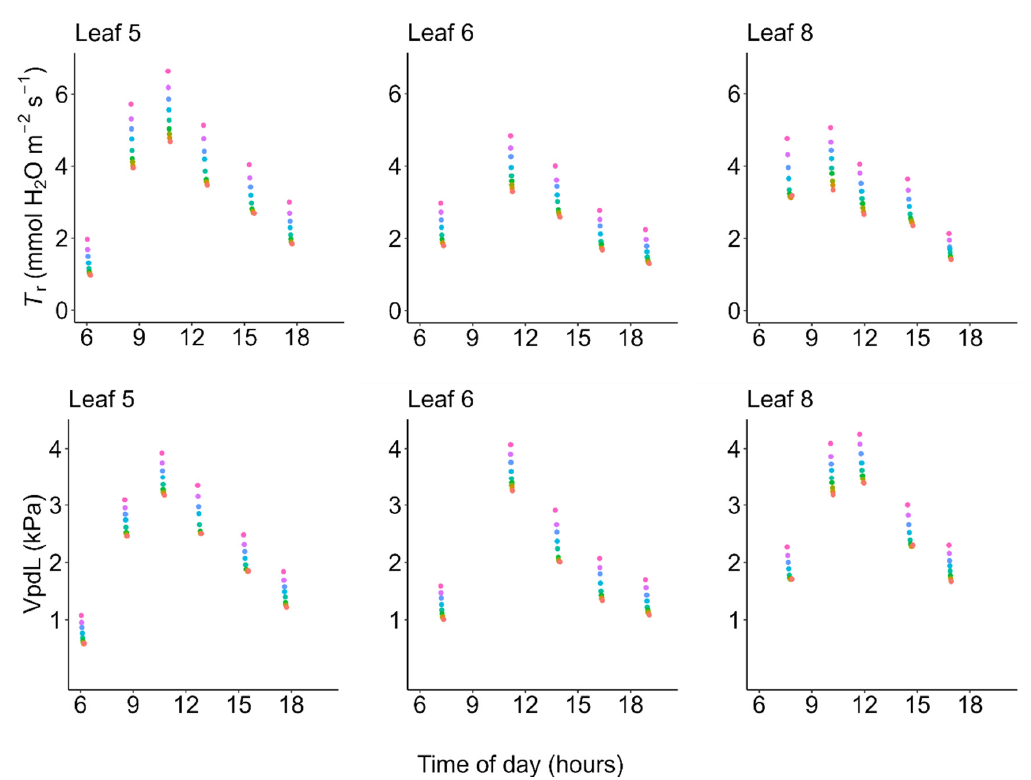
Figure 2. Diurnal courses of the light-response curves on a very hot day (19 July 2021). PPFD: photosynthetic photon flux density supplied with a light-emitting diode (LED) light source (LI-6400- 02B), P n : net photosynthetic rate, G s : stomatal conductance, T r : transpiration rate, and VpdL: vapor pressure deficit based on leaflet temperature. These values were measured with an LI-6400 system. All of the data are available in the Supplementary Materials.